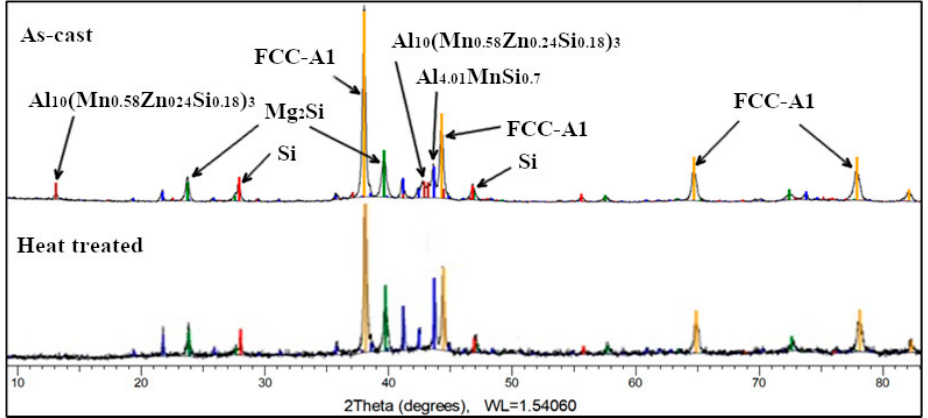
Figure 21. XRD results for as-cast and heat treated Al 3 Mn 0.2 Zn 0.3 Mg 0.7 Si 0.8 alloy.